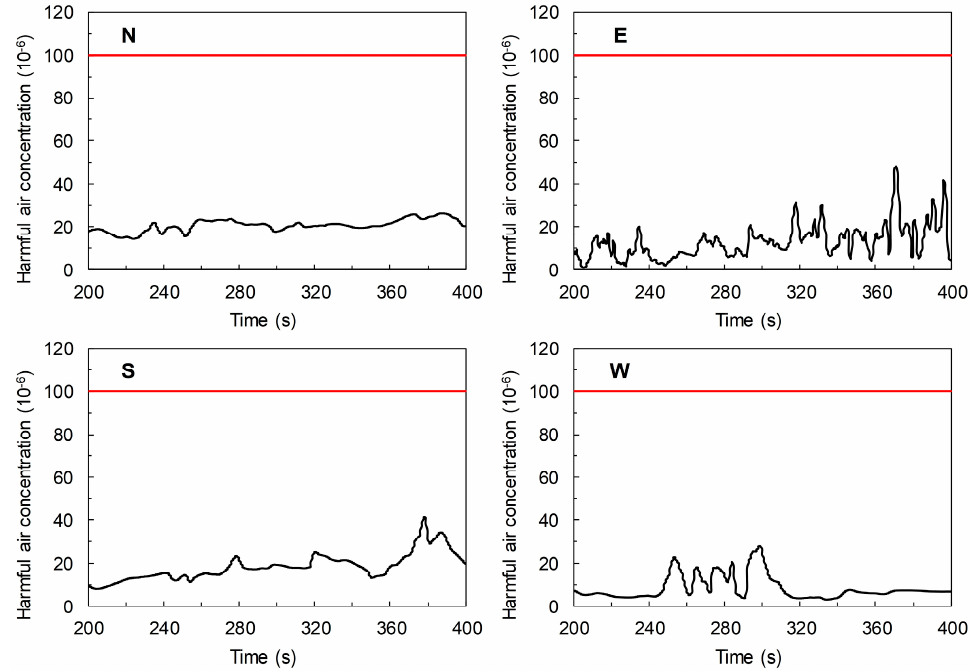
Figure 19. Time–history data of the harmful air concentration near the specific fresh-air intake with the highest instantaneous concentration under different wind directions.